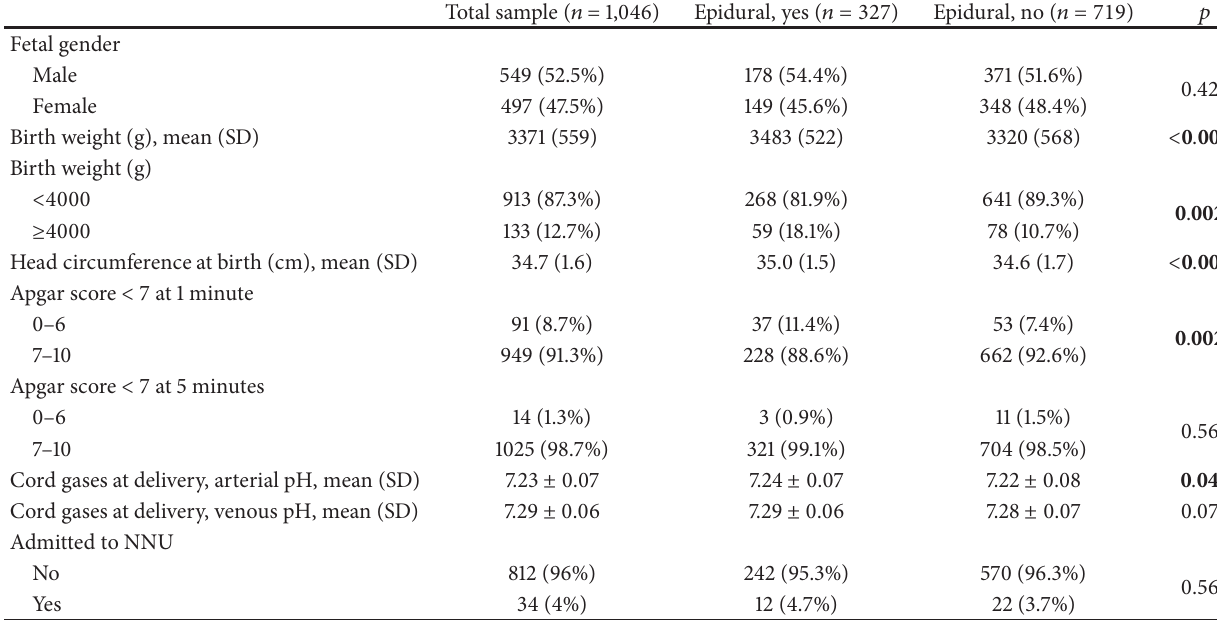
Table 2: Neonatal characteristics in the